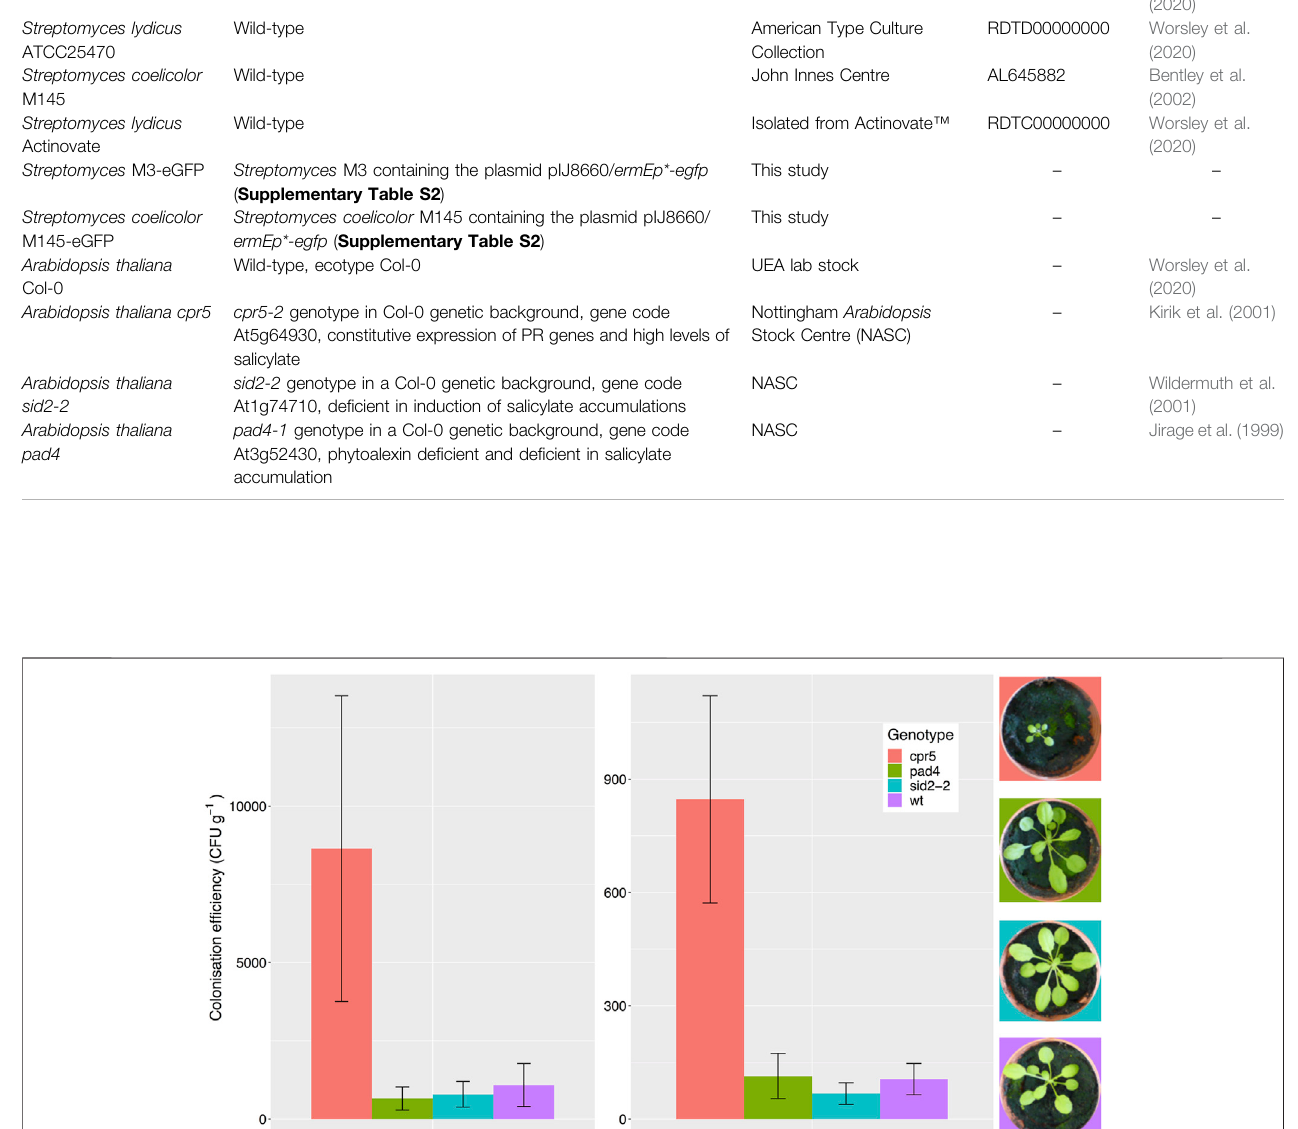
Frontiers in Molecular Biosciences |